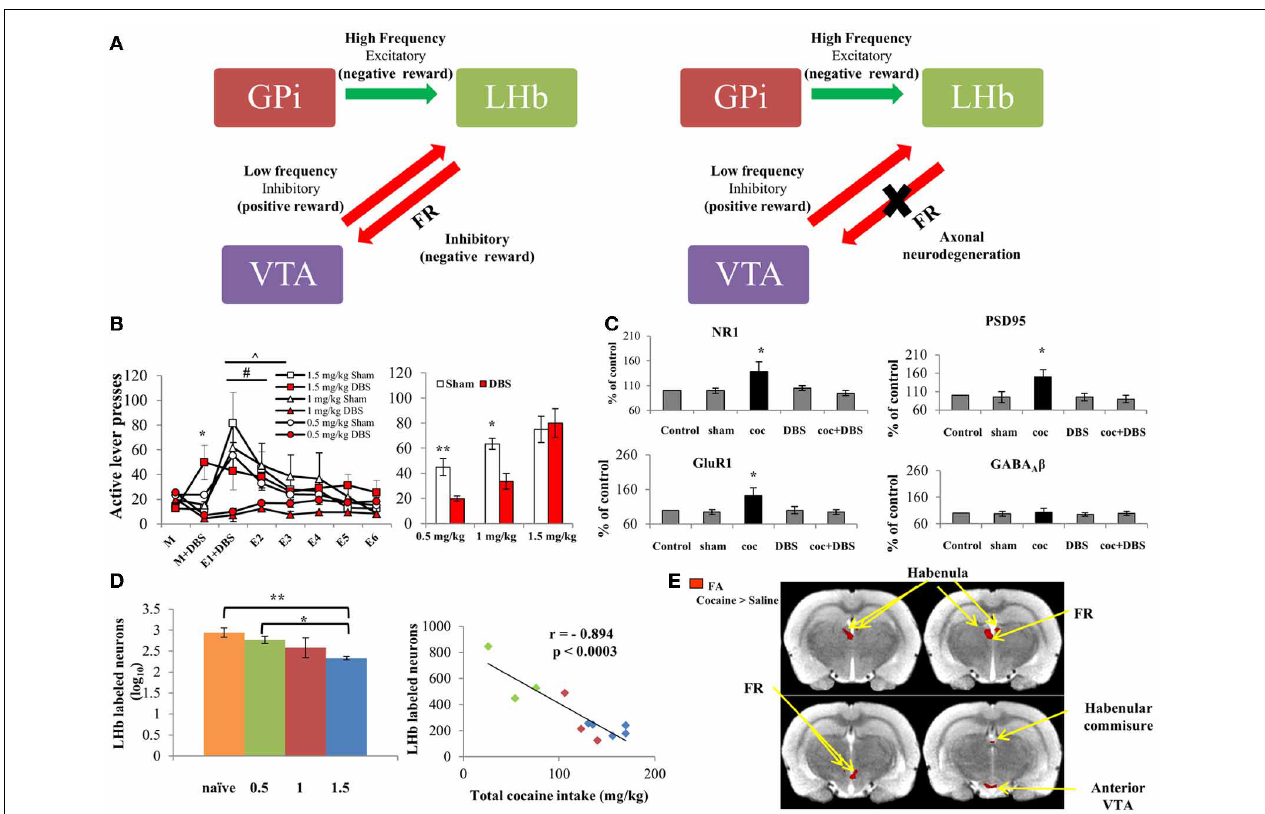
as mean ± SEM, in both graphs. (C) Effect of DBS of the LHb on levels of NR1, GluR1 and PSD95 in the VTA. Protein levels of the NR1 subunit of the NMDA receptor, GluR1 subunit of the AMPA receptor and scaffolding protein PSD95 were increased following cocaine self-administration (FR-1 schedule, 0.5mg/kg). DBS of the LHb in cocaine-trained rats restored NR1, GluR1 and PSD95 levels to normal. This effect was specific to the glutamatergic system, since levels of the GABA A receptor β subunits ( β 2 and β 3) remained unchanged. DBS alone did not alter levels of these proteins in the VTA (values are expressed as mean ± SEM). ∗ p < 0 . 001 for cocaine-treated rats (coc) vs. control, sham-operated, DBS-treated and cocaine + DBS-treated rats (coc + DBS). (D) Cocaine-induced FR neurodegeneration. Left: Labeled LHb neurons in cocaine-treated vs. naïve rats. One day after reaching stable maintenance levels in the self-administration paradigm (FR-1 schedule; 0.5, 1 or 1.5mg/kg; n = 3–5 per group), the amount of fluorogold-labeled LHb neurons was significantly reduced in 1.5mg/kg cocaine-treated rats as compared to 0.5mg/kg cocaine-treated ( ∗ p < 0 . 002) and naïve rats ( ∗∗ p < 0 . 001), indicating considerable neurodegeneration of the LHb-midbrain circuit at high dose cocaine. Values are expressed as mean ± SEM. Right: Correlation between total cocaine intake and labeled LHb neurons. A substantial, reverse correlation was found between the amount of labeled LHb neurons and total cocaine intake (mg/kg) ( r = − 0 . 894; p < 0 . 0003). (E) Statistical parametric maps of FA values for cocaine- vs. saline-treated rats. Rats were trained to self-administer cocaine (1.5mg/kg, n = 6) or saline ( n = 5) for 11 days. MRI followed by DTI analysis showed a significant increase in FA values in all regions of interest in rats which self-administered 1.5mg/kg cocaine, compared to controls. No difference in FA values was found in the ventral posterior thalamus and the substantia nigra (served as control ROI; Lax et al., 2013). With permission from Friedman et al. (2010); Lax et al.